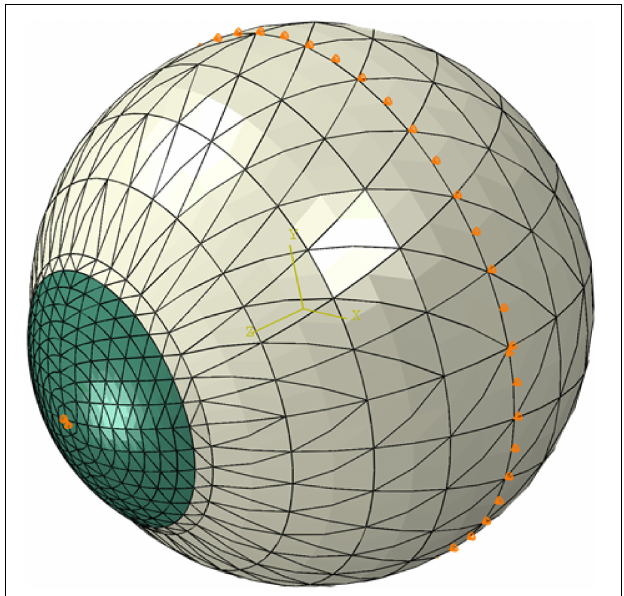
FIGURE 3 | A typical finite element model showing the boundary conditions applied at the equatorial nodes and corneal